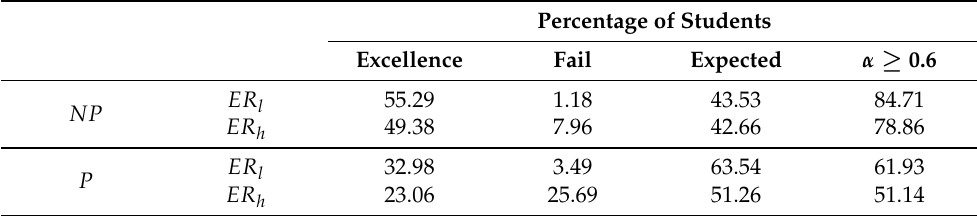
Table 11. Economic risk of the students that have not participated in the support program ( NP ) and the students that have participated, at least once, in the support program ( P